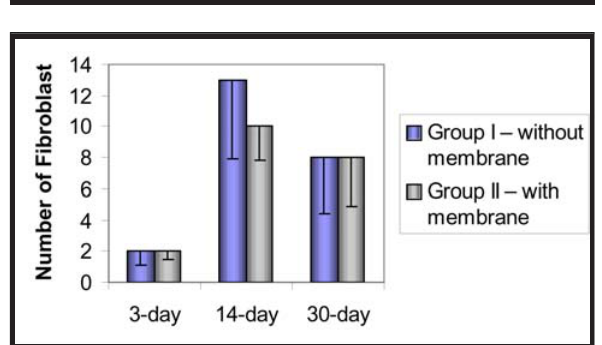
FIGURE 5 - Quantified distribution of fibroblasts (Mean- SD), in numerical values, as determined using image analysis